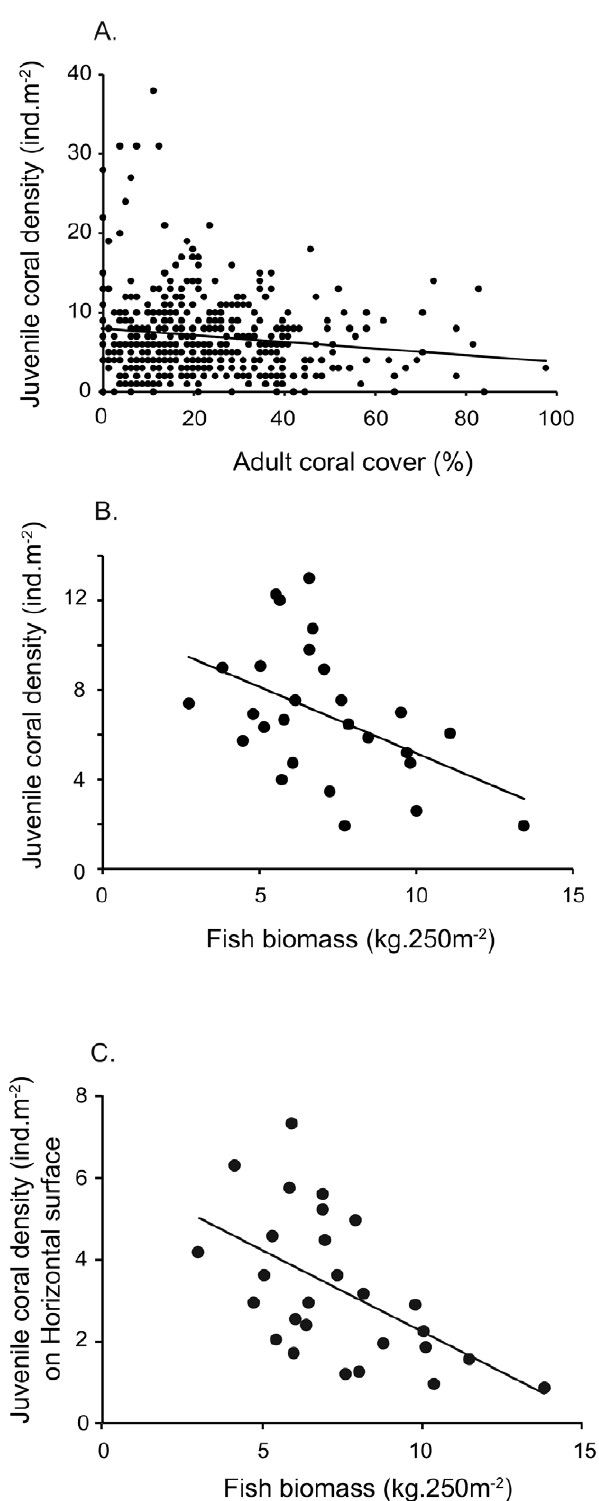
Figure 6. Relationship between (A) juvenile coral density and adult coral cover at quadrat scale, (B) juvenile coral density and the biomass of scraping and excavating parrotfishes at site scale, and (C) juvenile coral density on horizontal surfaces and the biomass of scraping and excavating parrotfishes at site